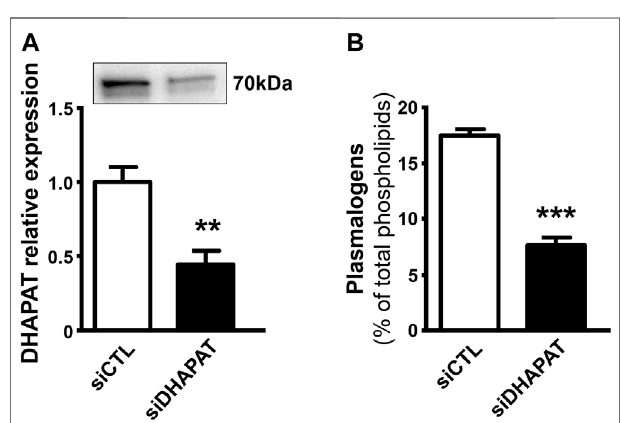
FIGURE 4 | Loss of DHAPAT expression in siDHAPAT-transfected Müller glial cells. (A) Western-blot analysis shows a signi fi cantly reduced expression of DHAPAT in primary Müller cells transfected with a DHAPAT- targeting siRNA (siDHAPAT) compared to control siRNA-transfected Müller cells (siCTL). (B) Plasmalogen concentrations determined by GC-FID are signi fi cantly reduced in siDHAPAT-transfected cells. Mann & Whitney test. ** p < 0.01; *** p < 0.001. n = 10. Data shown as mean ± SEM.